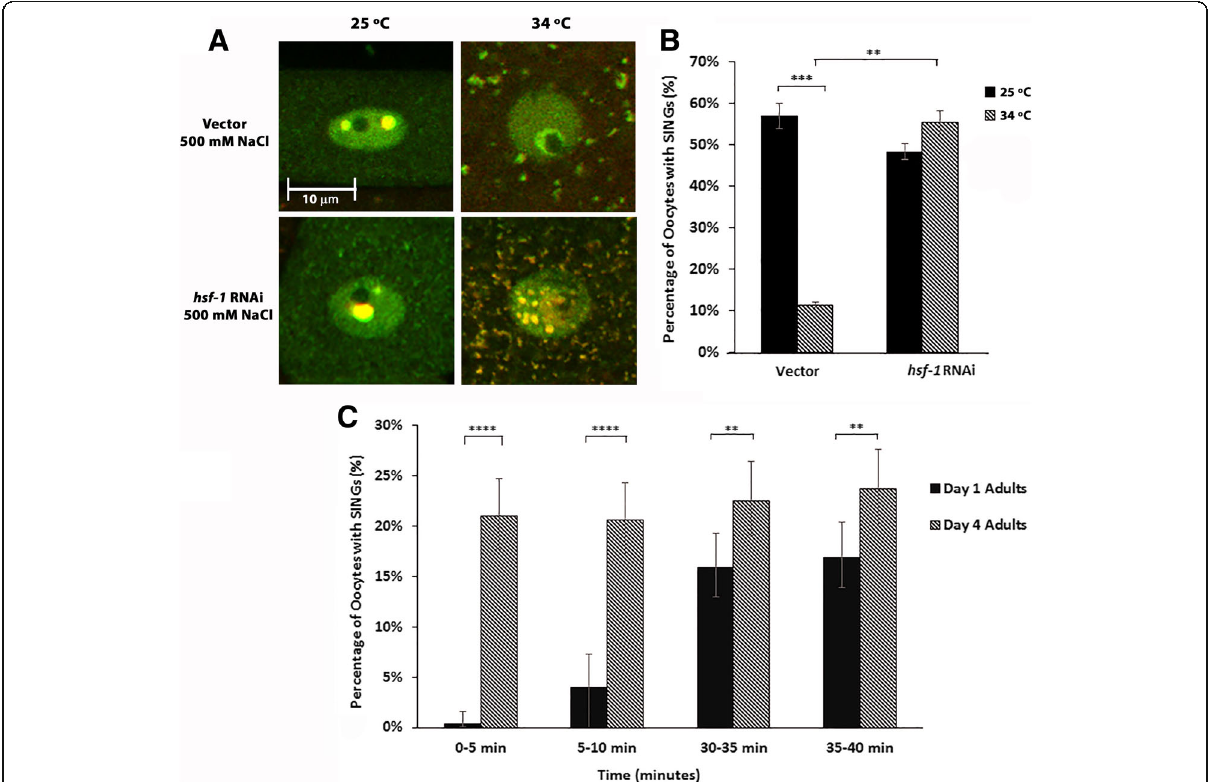
Fig. 2 SING formation correlates with reduced protein quality control. a Worms expressing GFP::Ub and RPT-1::mCh were incubated for 60 min at either 25 °C or 34 °C prior to soaking in 500 mM NaCl for 60 min. The merged image is shown. Areas that appear yellow have both GFP and mCherry. The brief heat shock reduced the occurrence of SING. Cytoplasmic granules also appear as a result of the heat shock. When hsf-1 was knocked down via RNAi, SING formation was normal even after heat shock. Scale bar indicates 10 μ m. b The percentage of oocytes forming SINGs as described in A. A total of 1020 oocytes were observed for each condition from 3 independent experiments ( n = 30 worms). Statistically relevant differences *** p < 0.0002, two-tailed z test. c Percentage of oocytes forming SINGs in day 1 and day 4 adults after exposure to 500 mM NaCl for the times indicated. A total of 510 oocytes were observed for each time point from 3 independent experiments ( n =30 worms). Statistical significance was calculated by a Fisher ’ s Exact test: ** p <0.01 and **** p